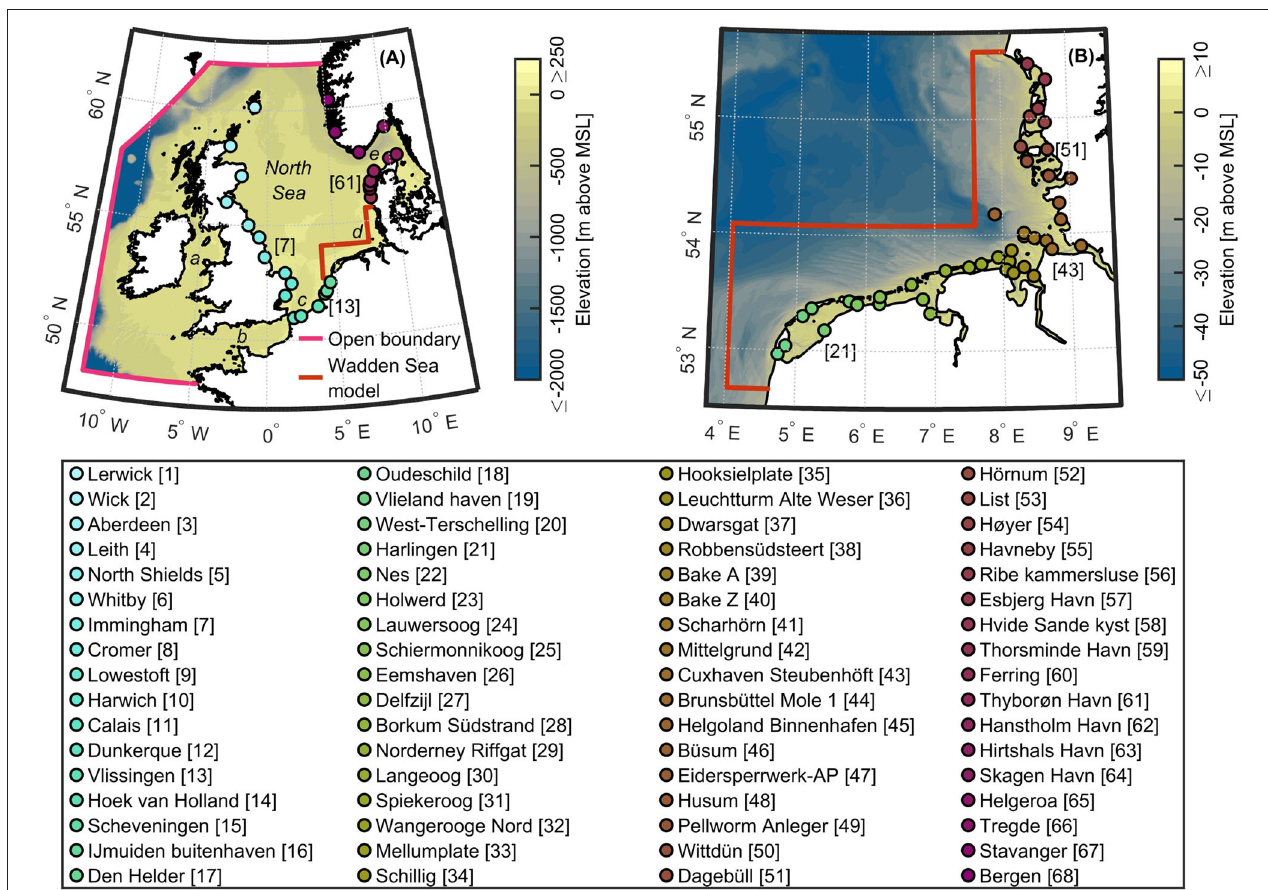
FIGURE 1 | Bathymetric maps for the study area. (A) Bathymetric map for the NWES, including model boundaries and locations of tidal gauges used for model validation. Additional information about the 68 tidal gauges is given in Supplementary Table1 . Letters a to e denote: (a) Irish Sea, (b) English Channel, (c) Southern Bight, (d) German Bight, and (e) Skagerrak. (B) Bathymetric map for the Wadden Sea, including model boundaries and locations of tidal gauges used for model